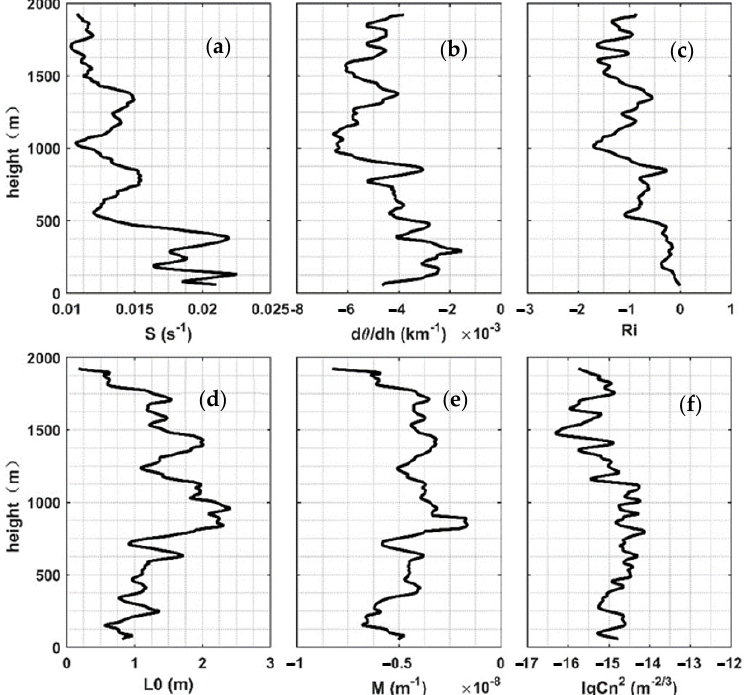
Figure 3. Average profiles of ( a ) wind shear, ( b ) potential temperature gradient, ( c ) Richardson number, ( d ) outer scale, ( e ) potential refractive index gradient and ( f ) C 2 n measured by all samples of balloon-borne radiosondes.